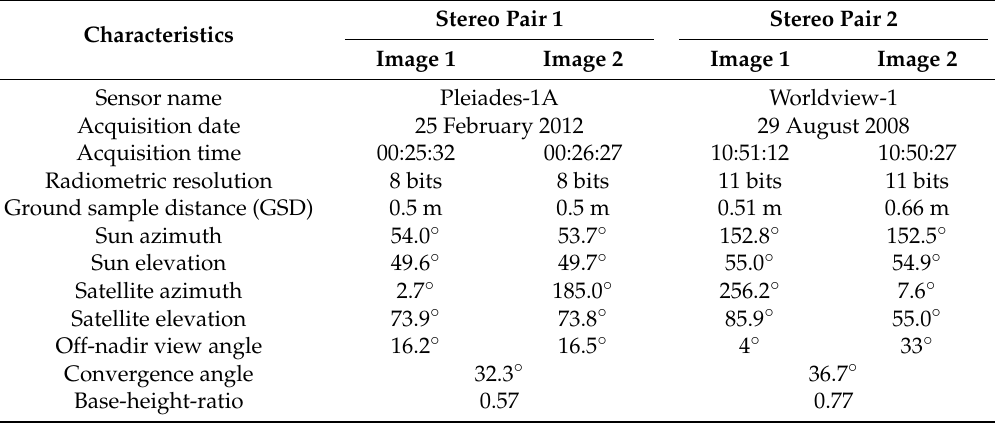
Table 1. Characteristics of two stereo